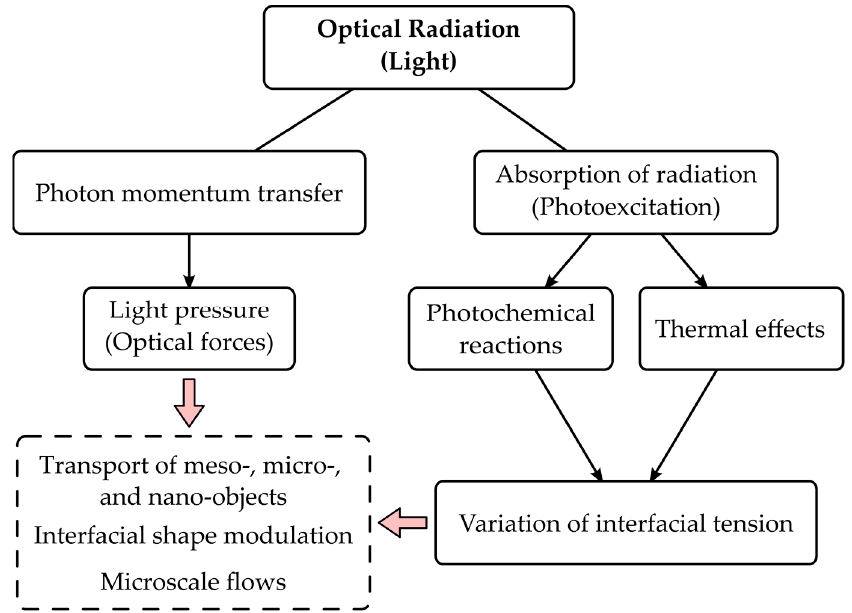
Figure 1. The ways of light energy conversion into kinetic energy of motion.